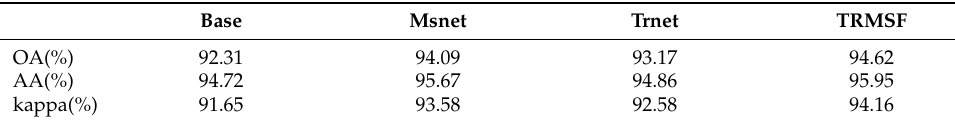
Table 3. Ablation study result on the Houston dataset